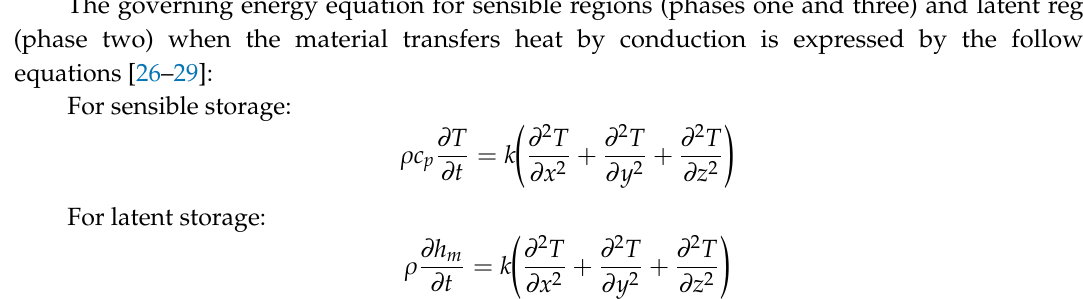
Figure 1. Heat storage mechanism in a PCM.